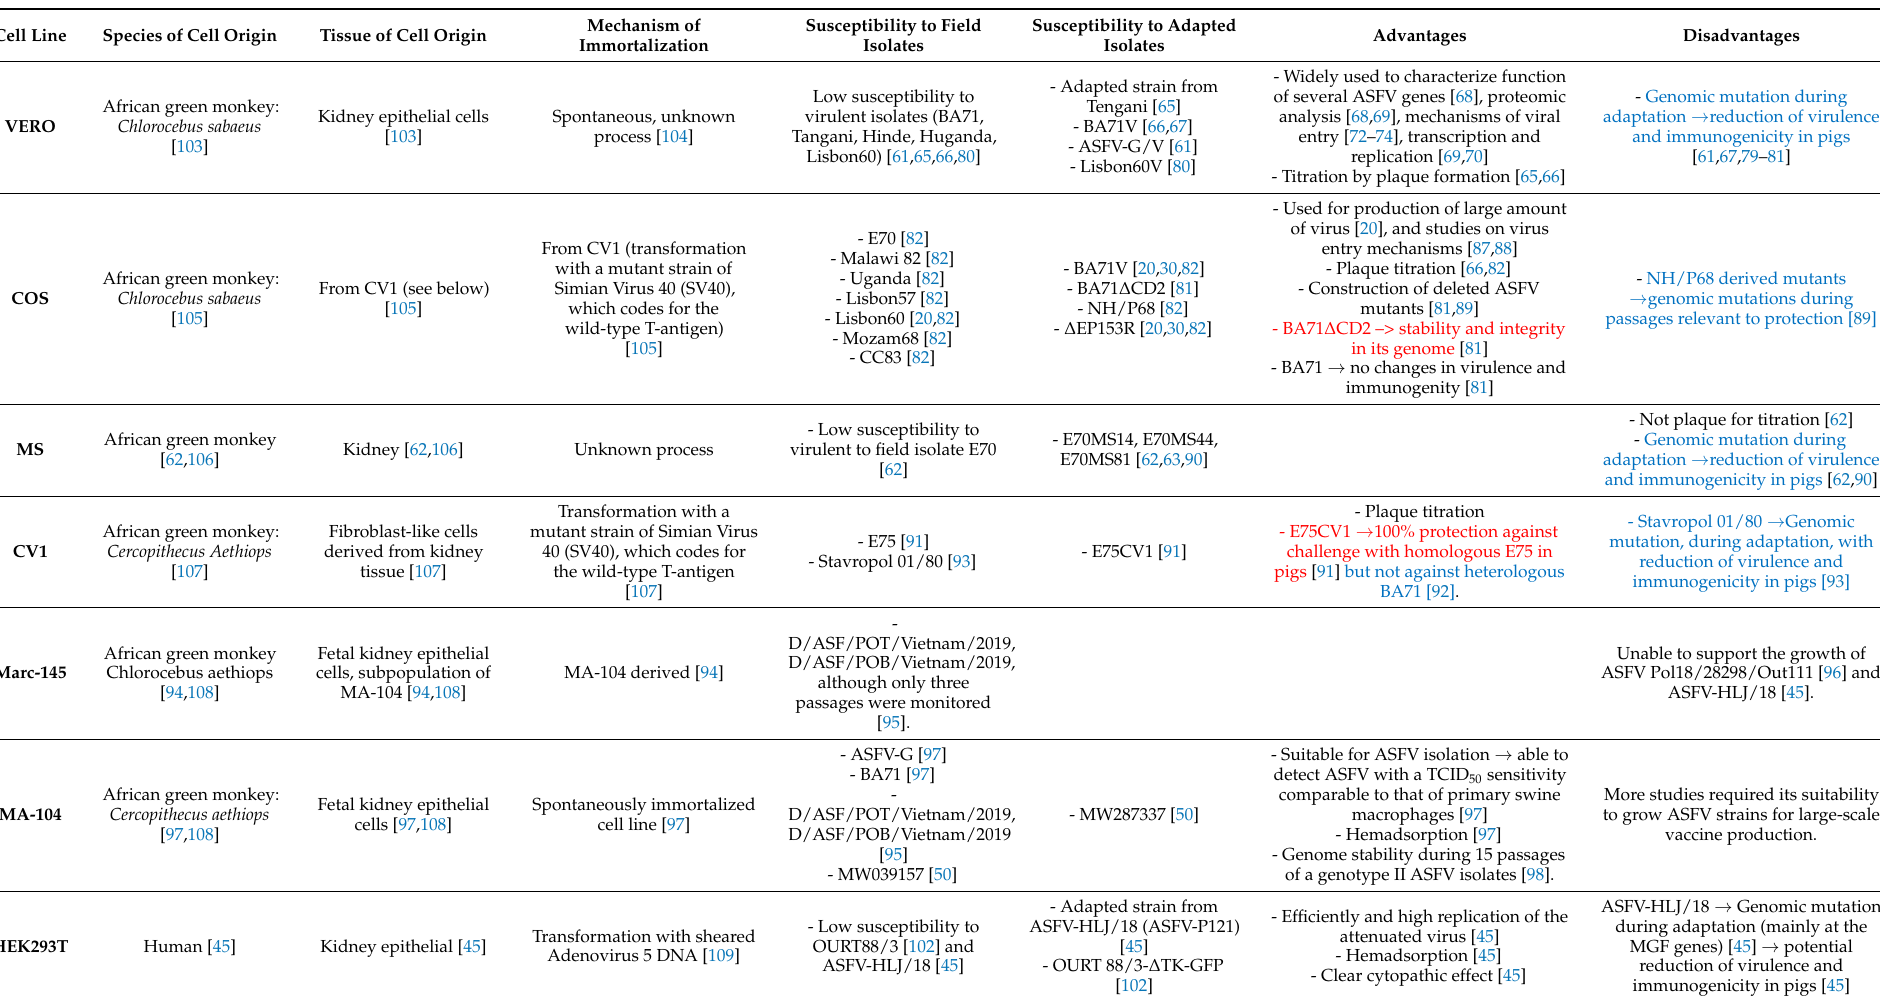
Table 1. Origin and characteristics of monkey-derived and human-derived continuous cell lines used for ASFV in vitro